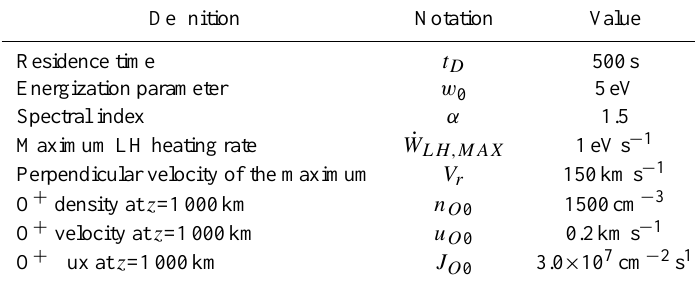
Table 3. List and values of parameters used as input to a numerical simulation associated with LH heating Definition